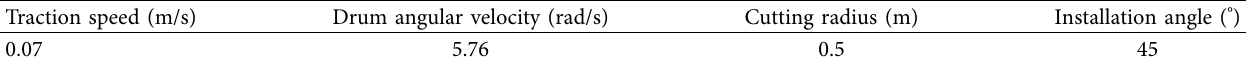
Figure 3: The process of conical pick cutting coal. Table 1: The cutting parameters of conical pick.